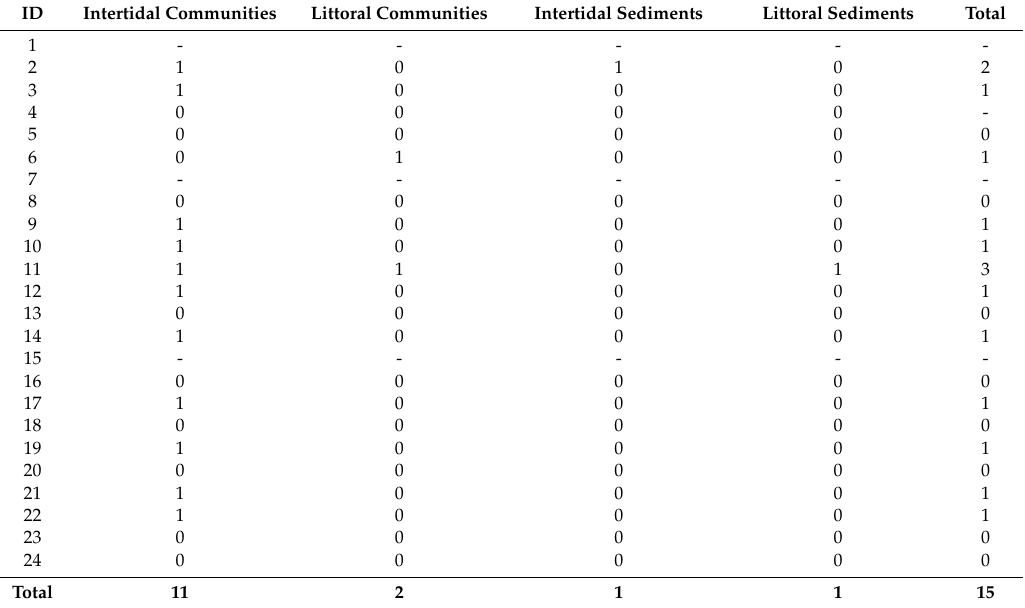
Table A3. Irrelevant descriptors identified in the monitoring of biological parameters.